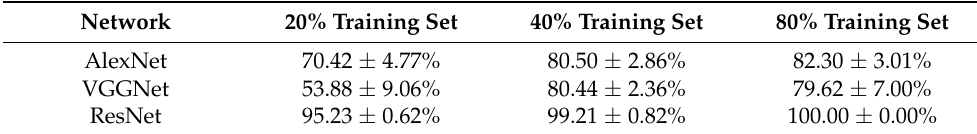
Table 7. Accuracy results for the data generated by our approach (256 ×